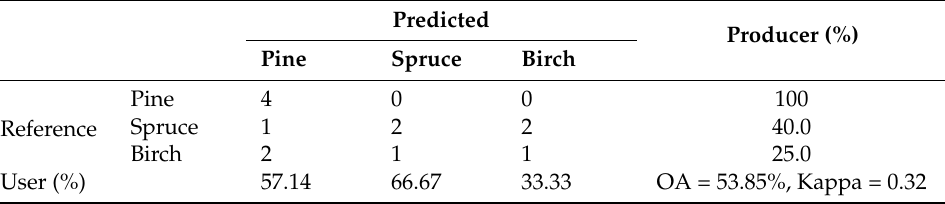
Table 13. Confusion matrix of classification with point cloud and intensity features for trees under a larger tree